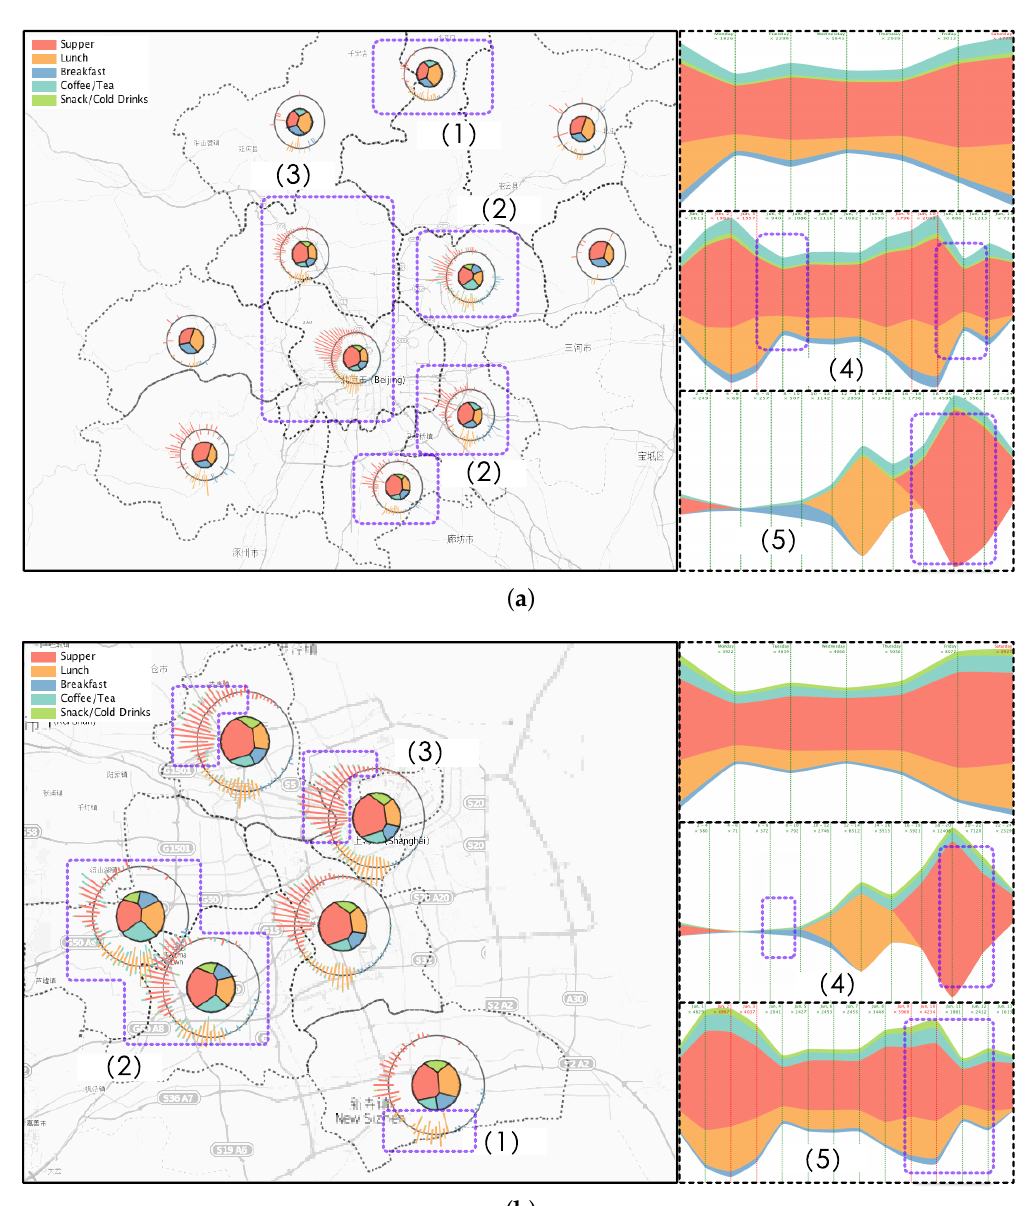
Figure 8. Case 1. The comparison between two regions in the same city and regions from two different cities, show quite different spatial and activity patterns. ( a ) Regional Fingerprinting of Beijing Dinning Behavior. (1) A region’s users choose to have lunch on weekends; (2) Three adjacent regions with more active users on weekdays; (3) A very functional region with all activity types and the popular check-in users; (4) An expected decrease every Monday; (5) Supper for people living in Beijing normally started from 18:00 but slowly decreased by 20:00 then experienced a sharp downturn; ( b ) Regional Fingerprinting of Shanghai Dinning Behavior. (1) A region users choose to have lunch on weekends; (2) Two neighboring regions with similar temporal evolution; (3) A functional region with all activity types and popular check-in users; (4) Supper taken by people living in Shanghai started a little earlier than people in Beijing from 16:00 but dramatically decreased by 20:00; (5) An expected decrease every